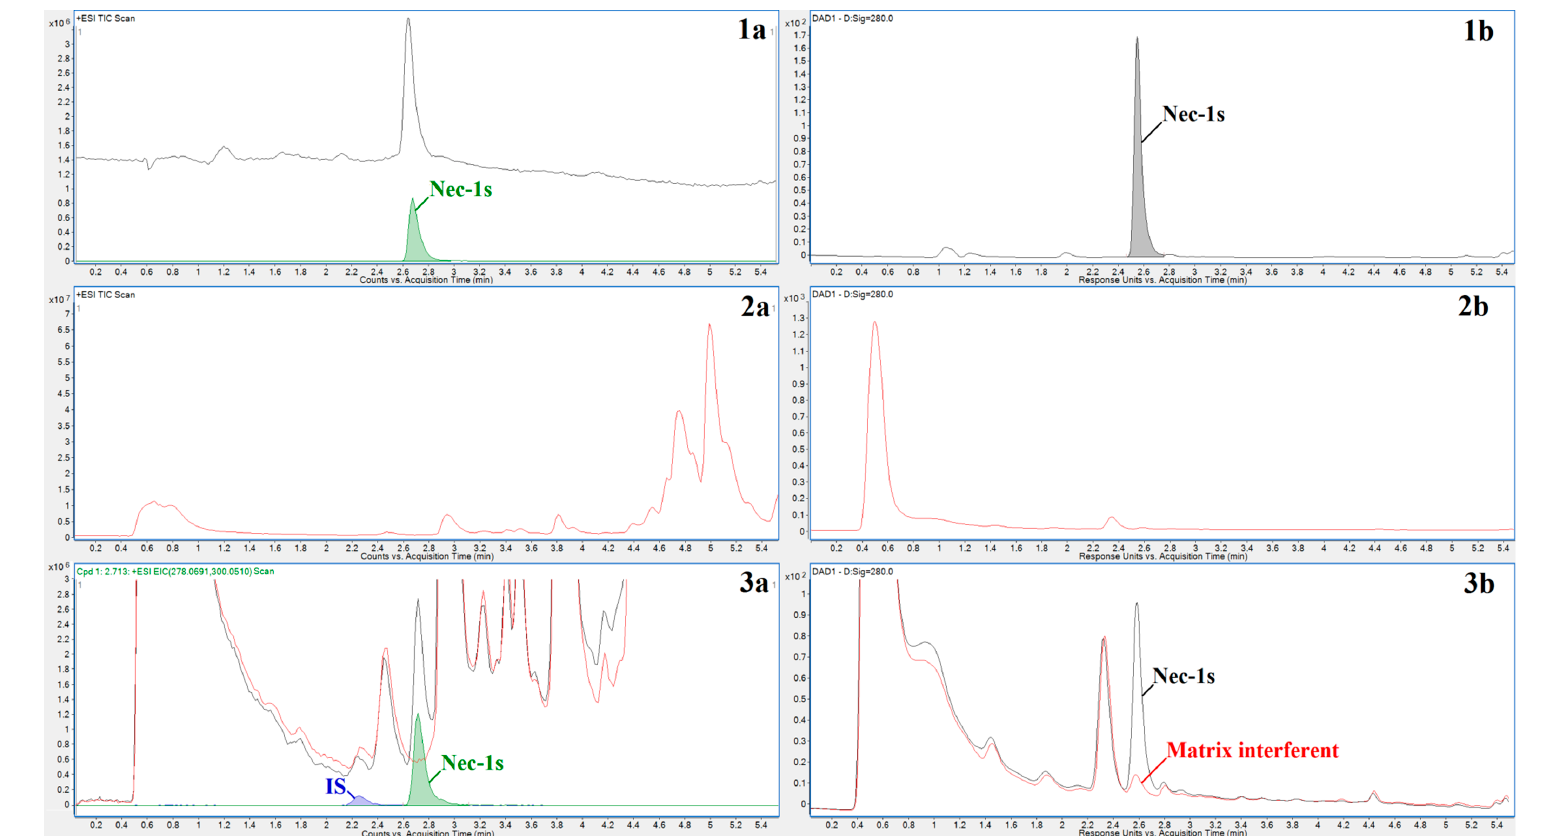
Figure 2. Representative chromatograms of Nec-1s in standard and plasma matrices obtained by the HPLC-DAD-Q-TOF method. MS ( a ) and DAD ( b ) profiles of: Nec-1s standard stock solution ( 1 ), blank plasma solution–whole chromatogram ( 2 ), detail of blank plasma solution (red line) overlapped with spiked plasma solution at a 2030.00 ng/mL concentration of Nec-1s (black line) ( 3 ). Blue and green integrated peaks in ( 3a ) represent EIC of IS and Nec-1s, respectively. Optimum chromatographic and detection (UV, MS) conditions, as given in Sections 3.6. and 3.5., respectively, were used to obtain the present profiles.